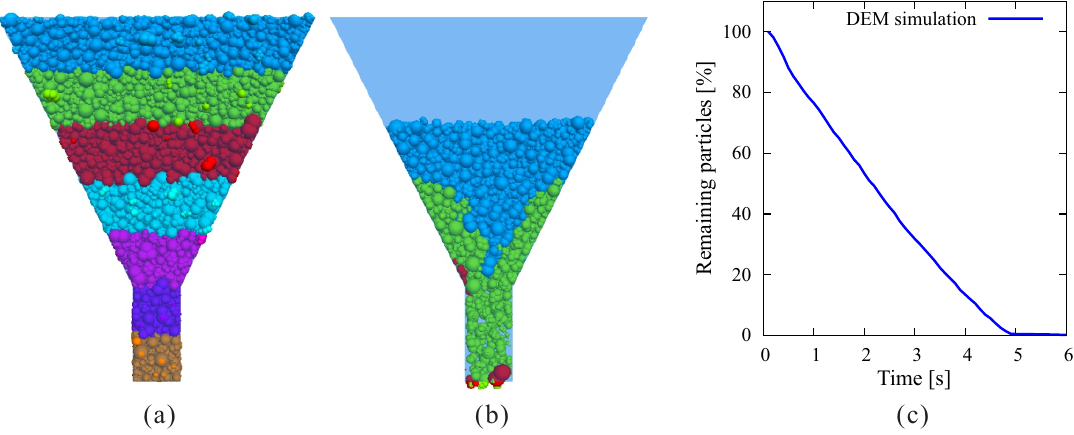
Figure 5. Verification of DEM model with V-funnel test: ( a ) initial state; ( b ) flow status at time = 2.5 s; and ( c ) evolution of remaining particle